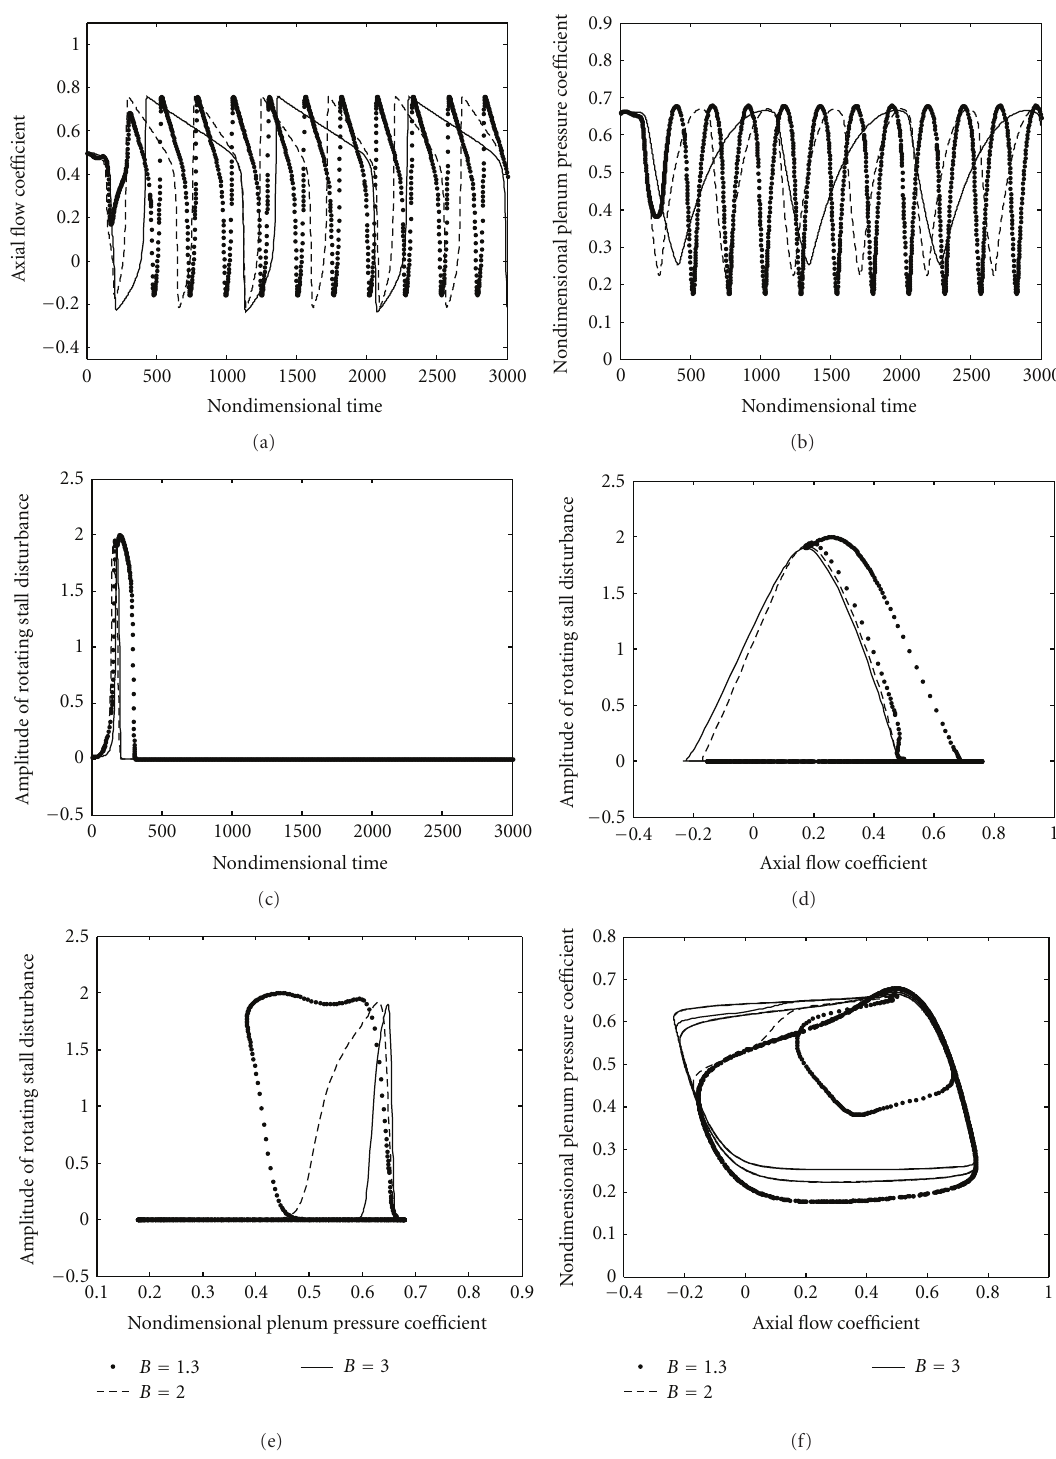
Figure 15: E ff ect of increase in B parameter from 1.3 to 3: variation of nondimensional flow properties (a), (b), and (c) with time. (a) Axial flow coe ffi cient, (b) plenum pressure rise coe ffi cient, and (c) disturbance amplitude of rotating stall. (d) Variation of axial flow coe ffi cient with disturbance amplitude of rotating stall. (e) Variation of plenum pressure rise coe ffi cient with disturbance amplitude of rotating stall. (f) Limit cycle oscillation: axial flow coe ffi cient versus plenum pressure rise coe ffi